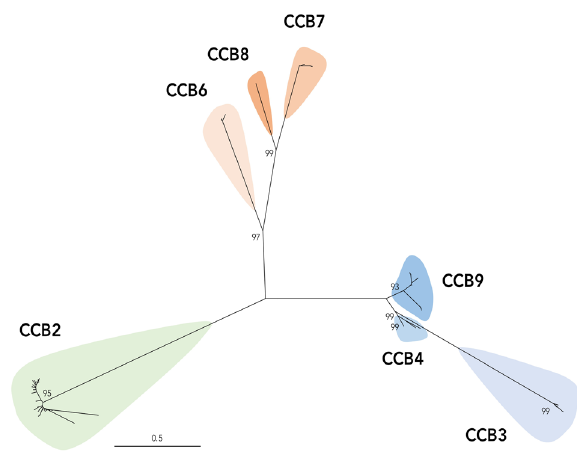
Fig. 1 Phylogenetic analysis of anti-Gardnerella endolysin candi- date library. Individual families are denoted by coloured clades. Selected bootstrap values of >95% are shown for clarity. CCB2 homologues are described previously 16